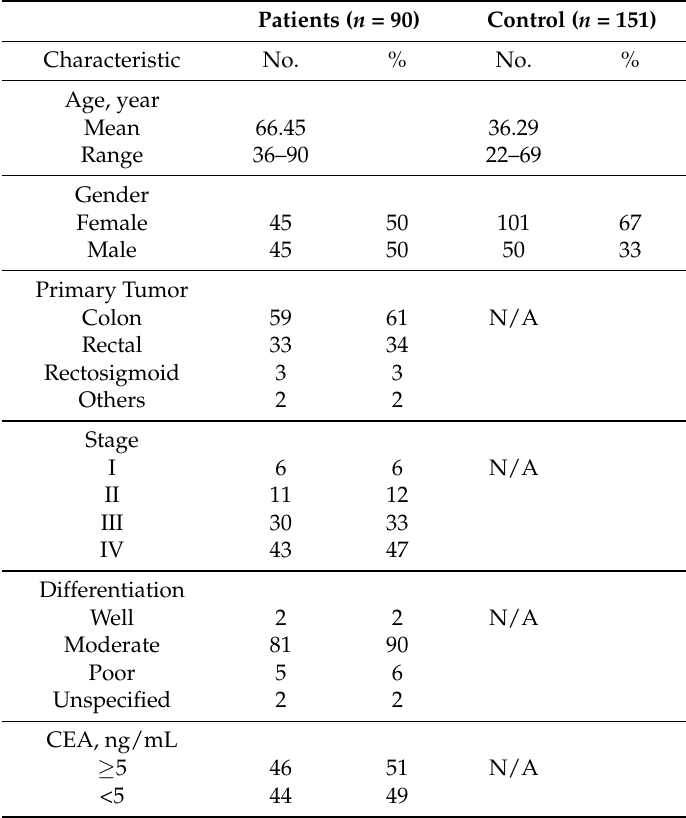
Table 1. Characteristics of colorectal patients and healthy